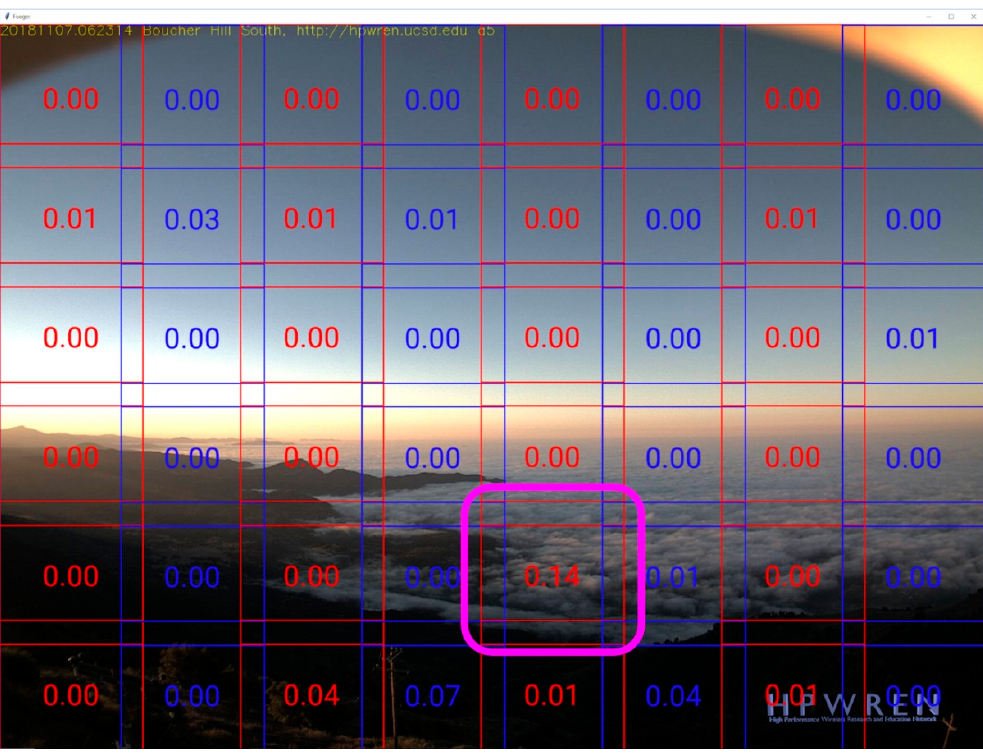
Figure 4. True negative image, where fog is correctly not classified as smoke. Highest scoring segment scored 0.14 and is highlighted. Remote Sens. 2020 , 12 , x FOR PEER REVIEW